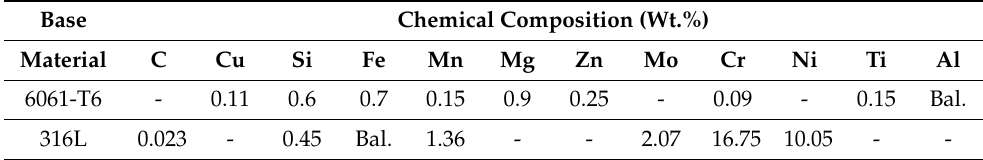
Figure 1. Schematic diagram of the FSW experiment. ( a ) Schematic diagram of tool displacement; ( b ) Cross-sectional diagram in Figure. 1 ( a ). Table 1. Chemical composition of the base